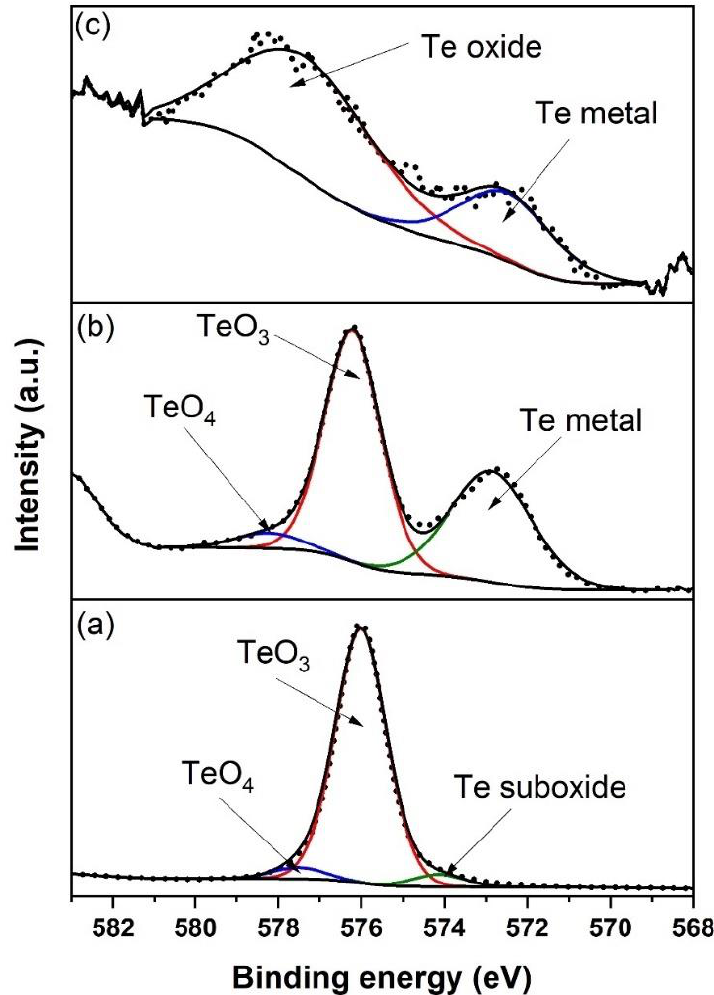
Figure 5. Te 3d 5/2 spectra of the surface of EDTS layer for samples prepared at ( a ) 400 °C (B400), ( b ) 570 °C (B570), and ( c ) 700 °C (B700).